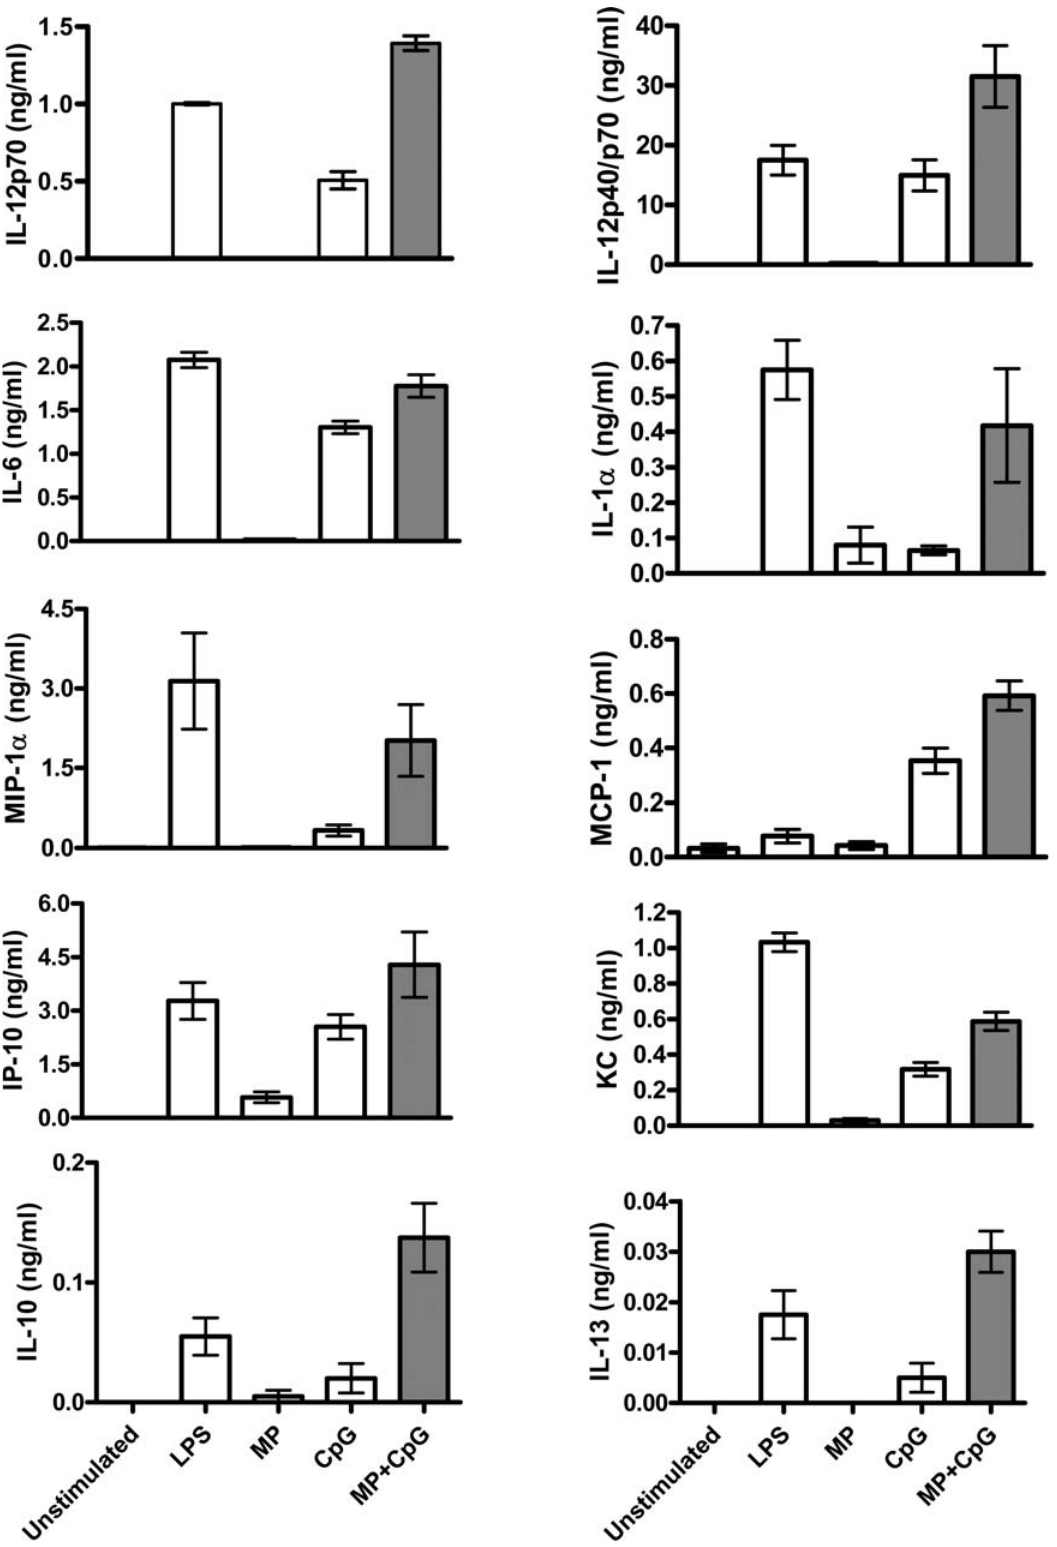
Figure 2. MP synergizes with CpG to stimulate cDC to produce proinflammatory cytokines, chemokines, and immunoregulatory cytokines. cDCs were stimulated as in Figure 1. Data are means 6 SEM of 4 independent experiments. p , 0.001 comparing MP alone with MP + CpG and p , 0.05 comparing CpG alone with MP + CpG for IL-6 and IL-12p40/p70. p , 0.001 comparing MP alone with MP + CpG and p , 0.01 comparing CpG alone with MP + CpG for KC and MCP-1. p , 0.05 comparing MP alone or CpG alone with MP + CpG for MIP-1 a . p , 0.01 comparing MP alone with MP + CpG for IP-10. p , 0.01 comparing MP alone or CpG alone with MP + CpG for IL-10. p , 0.001 comparing MP alone or CpG alone with MP + CpG for IL-12p70 and IL-13. All statistical comparisons were by one way ANOVA with Tukey’s multiple comparison test. doi:10.1371/journal.pone.0002046.g002 PLoS ONE |